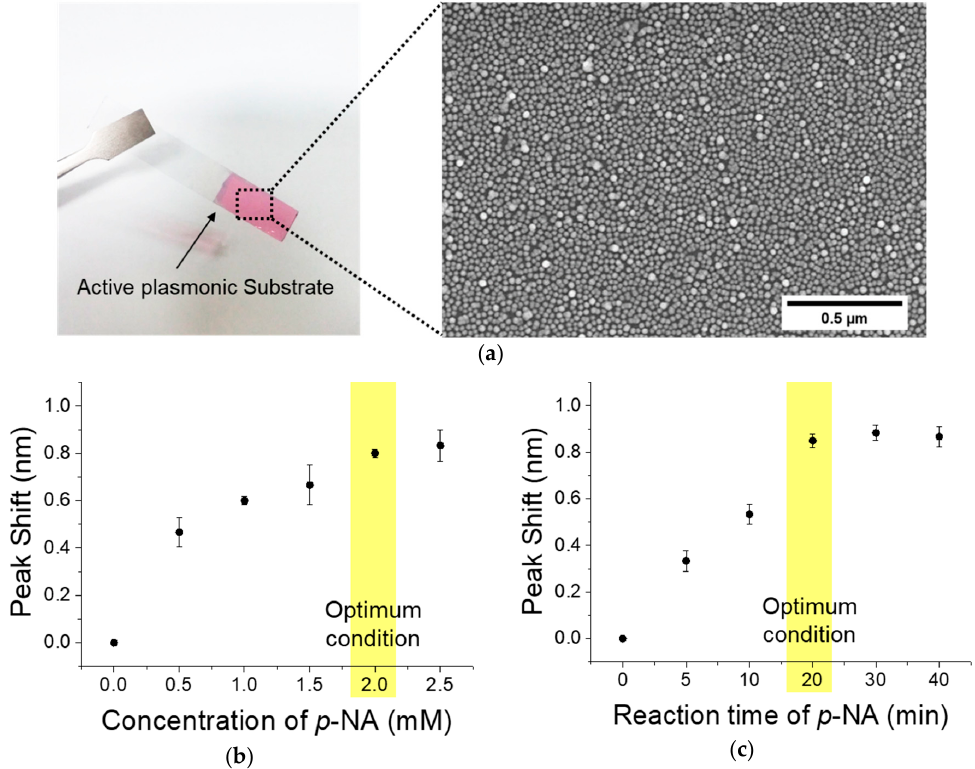
Figure 1. Optimum conditions for melamine detection by p- NA-based localized surface plasmon resonance sensor chip. ( a ) Optical (left) and scanning electron microscopy (right) images of an optimized plasmonically active substrate. Effect of the p- NA ( b ) concentrations and ( c ) immobilization time on the plasmonically active substrate. All experiments were performed with five measurements, and the data represent mean ± standard